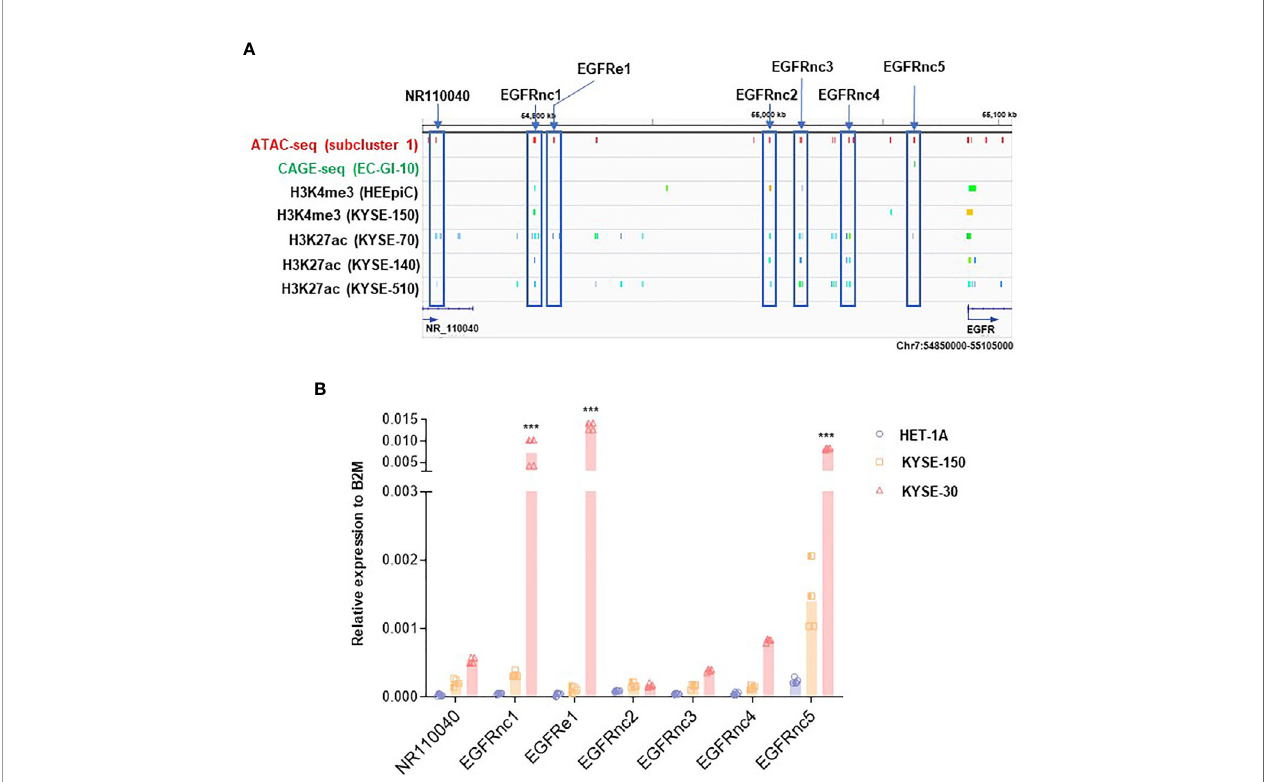
FIGURE 3 | Identi fi cation of non-coding RNAs (ncRNAs) near EGFR upregulated in KYSE-30 cells. (A) Multi-omics analysis approach revealed non-coding RNAs upstream of EGFR that are overlapped with both hyper-accessible regions in KYSE-30 cells (ATAC-seq peaks) and potential enhancer regions in other ESCC cells (CAGE-seq or H3K27ac peaks). Various colors in each ChIP-seq row indicate different peaks that are generated from one sequencing result. Blue boxes highlight the non-coding RNAs tested in this study. (B) Expressions of ncRNAs in HET-1A, KYSE-150, and KYSE-30 cells were measured by digital droplet PCR, and their copy numbers relative to the copy numbers of B2M, a commonly used housekeeping gene, are shown. Two technical replicates from two biological replicates are displayed. *** p -value < 0.001 compared to each gene in HET-1A